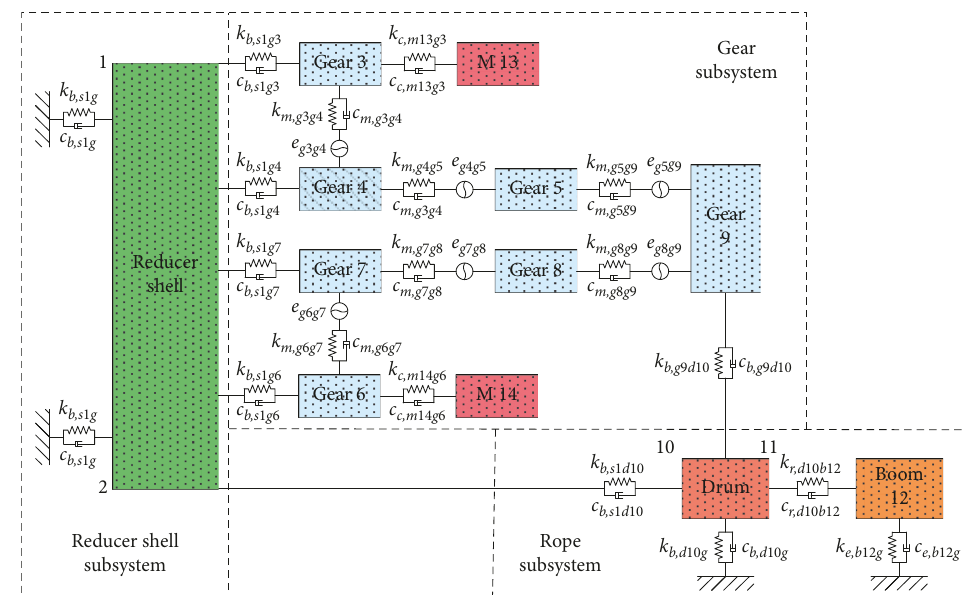
Figure 3: Dynamic model of mechanical system.